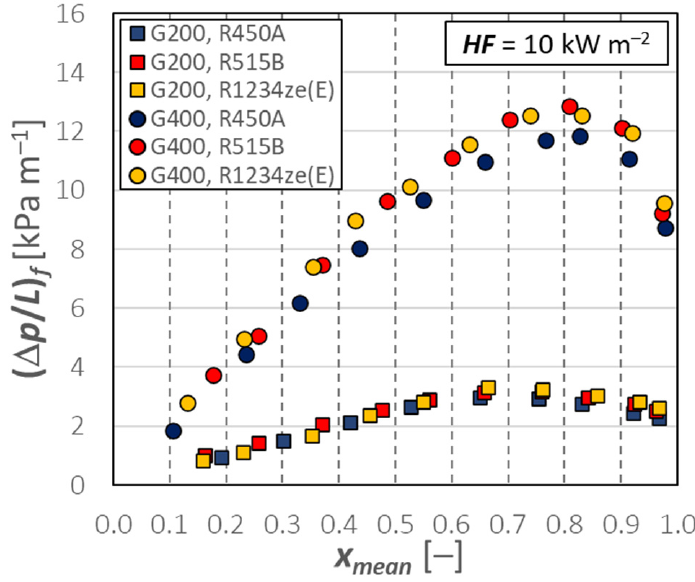
Figure 7. Frictional pressure gradient of R450A, R515B, and R1234ze(E) vs. mean vapor quality at t sat = 30 °C. G200 = 200 kg m − 2 s − 1 and G400 = 400 kg m − 2 s − 1 .